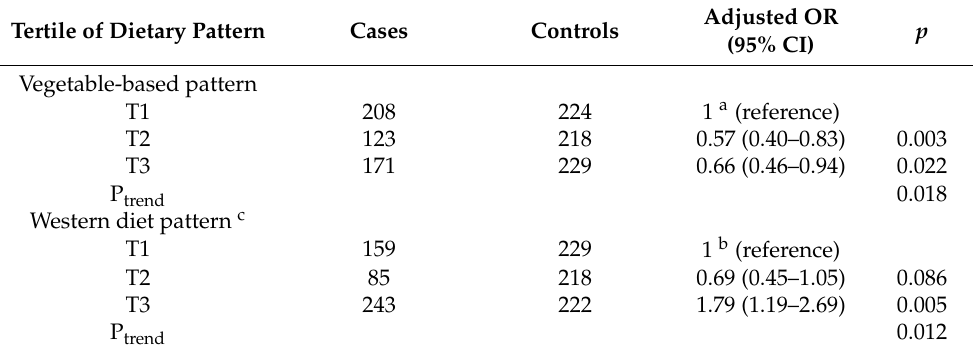
Table 5. Multivariable adjusted ORs and 95% CI for hepatocellular carcinoma according to dietary pattern tertile.